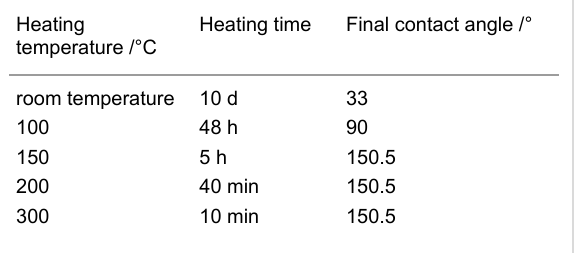
Table 2: Changes in the contact angle of a superhydrophilic coating (obtained by charging at 2000 V and 150 °C for 2 min) with heating temperature and heating time.